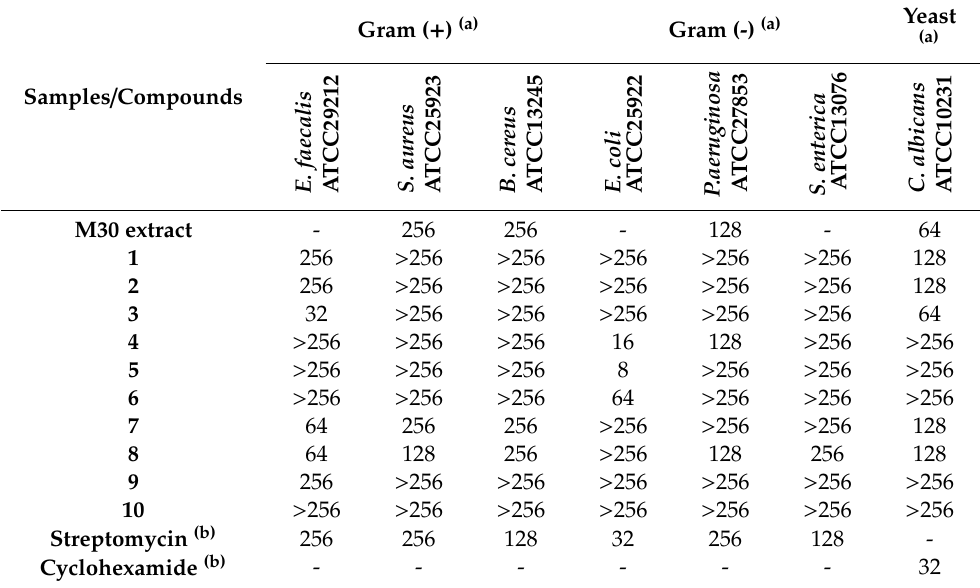
Table1. Minimuminhibitoryconcentrationvaluesofextractandisolatedmetabolitesfrom Penicillium sp.